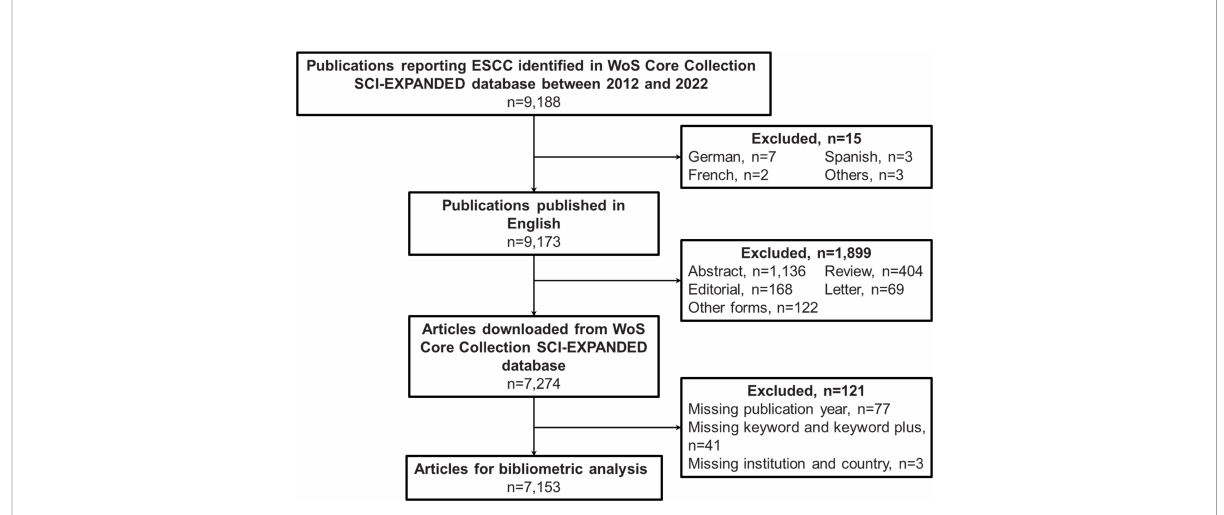
FIGURE 1 Flowchart for screening eligible articles. WoS, Web of Science; SCI-EXPANDED, Science Citation Index Expanded.